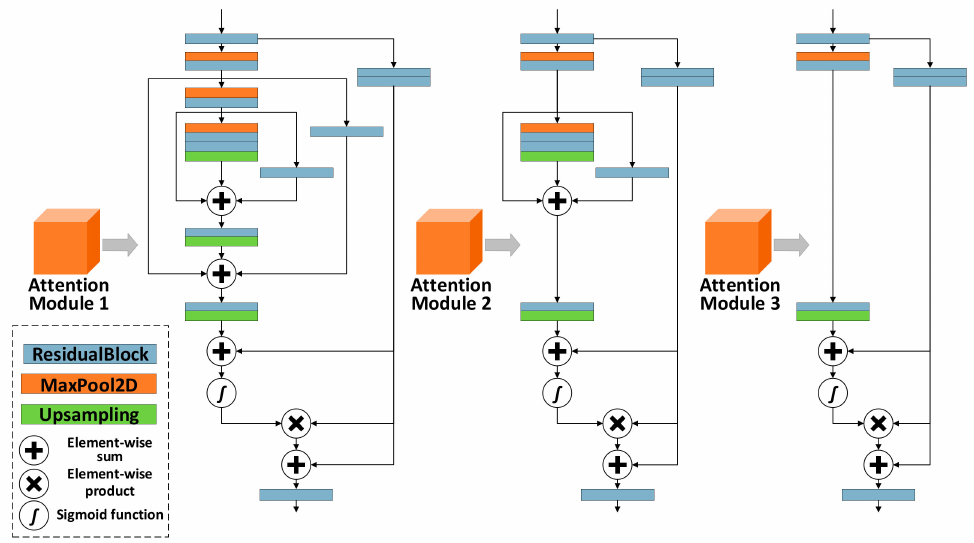
Figure 11. Structures of attention modules 1, 2, 3.